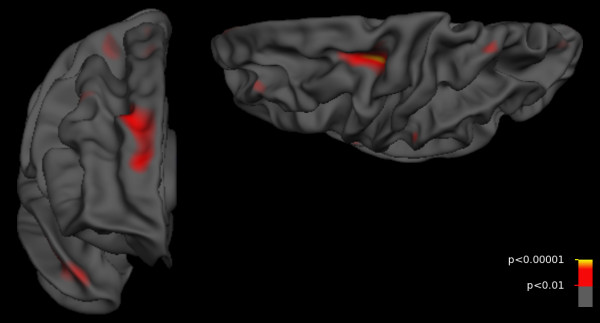
Cortical thickness differences between controls and long-term alcohol using amphetamine dependent subjects. Controls showed trends towards thicker cortex than patients with ten or more years of heavy alcohol use (A≥10 vs control) in superior-frontal regions. Views are rostral right hemisphere and dorsal left hemisphere. P-values are uncorrected. No results survive after controlling the FDR at a 5% level. Colors are coded by (-log10), with red indicating p = 0.01 and yellow indicating p < 0.00001.